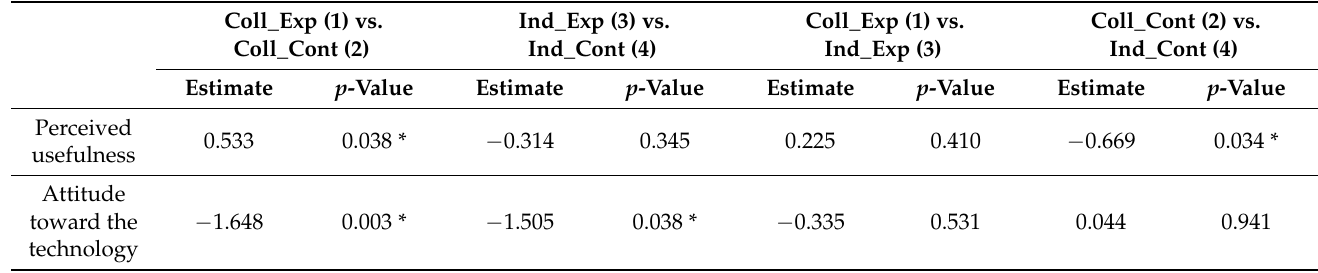
Table 2. Impact of immersion and collectivity on behavioural